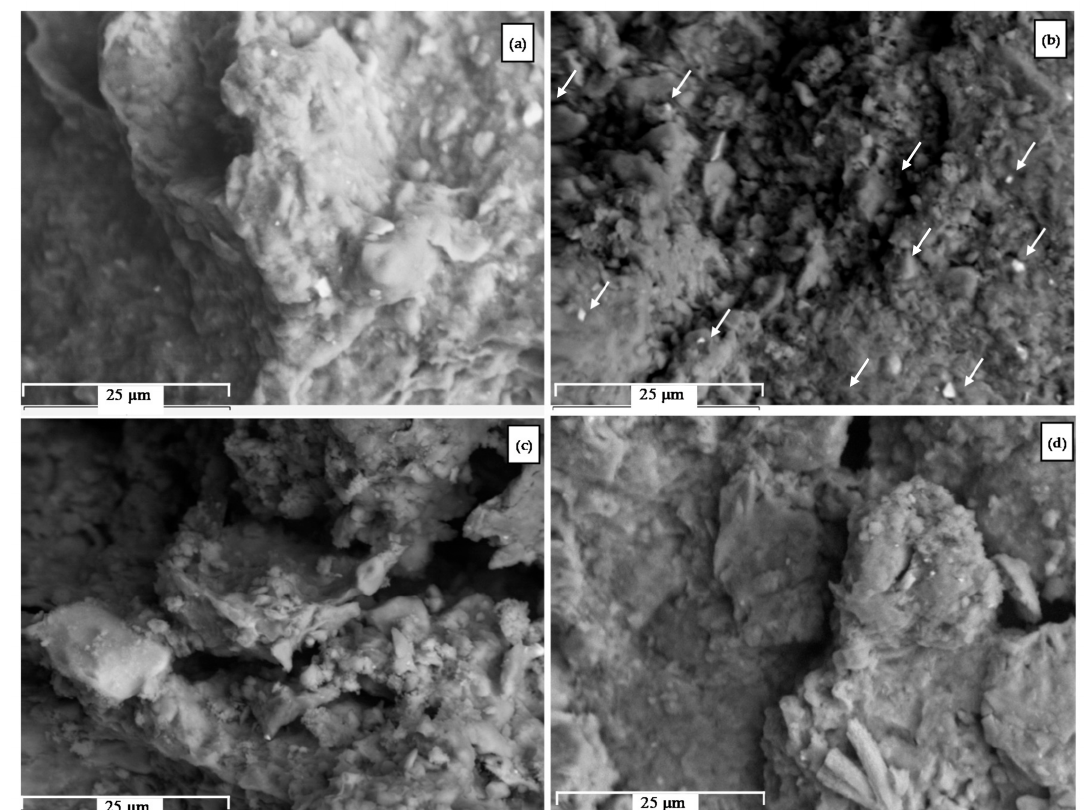
Figure 8. Summary of SEM micrographs of soil stabilised with ( a ) 0% stabiliser, ( b ) 4% HL, ( c ) 4% BFS/HL and ( d ) 4% Portland